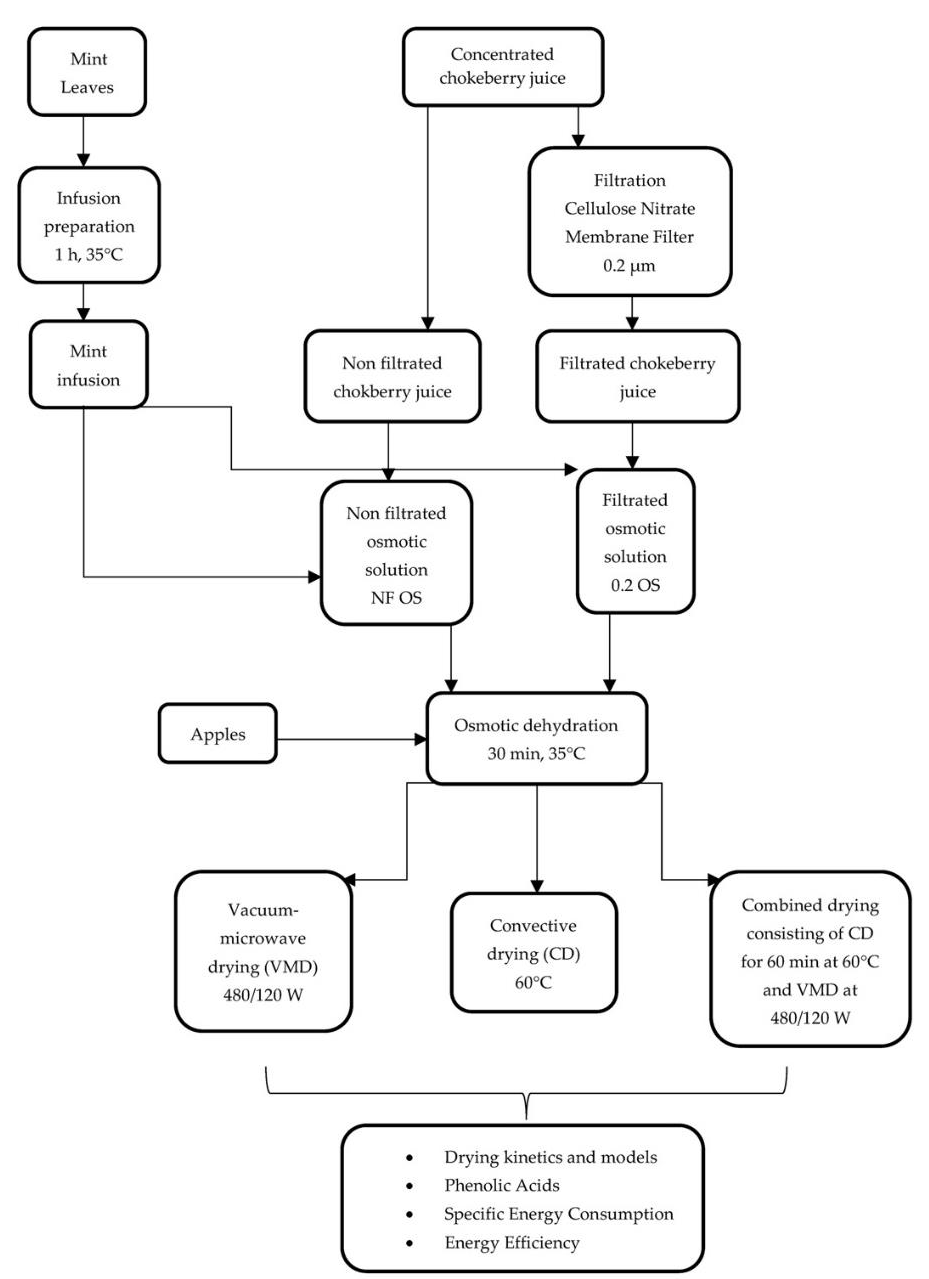
Figure 5. Process flow chart.